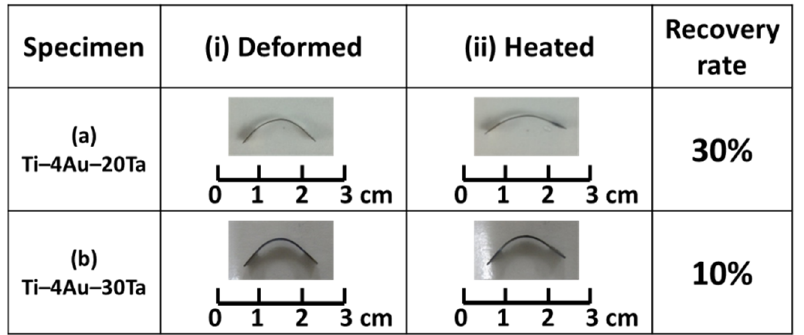
Figure 3. Bending tests of the ( a ) Ti–4Au–20Ta alloy and the ( b ) Ti–4Au–30Ta alloy for the examinations of the shape memory effect and shape recovery rates. Stage ( i ) corresponds to after bending deformation while stage ( ii ) indicates shape recovery upon heating process.